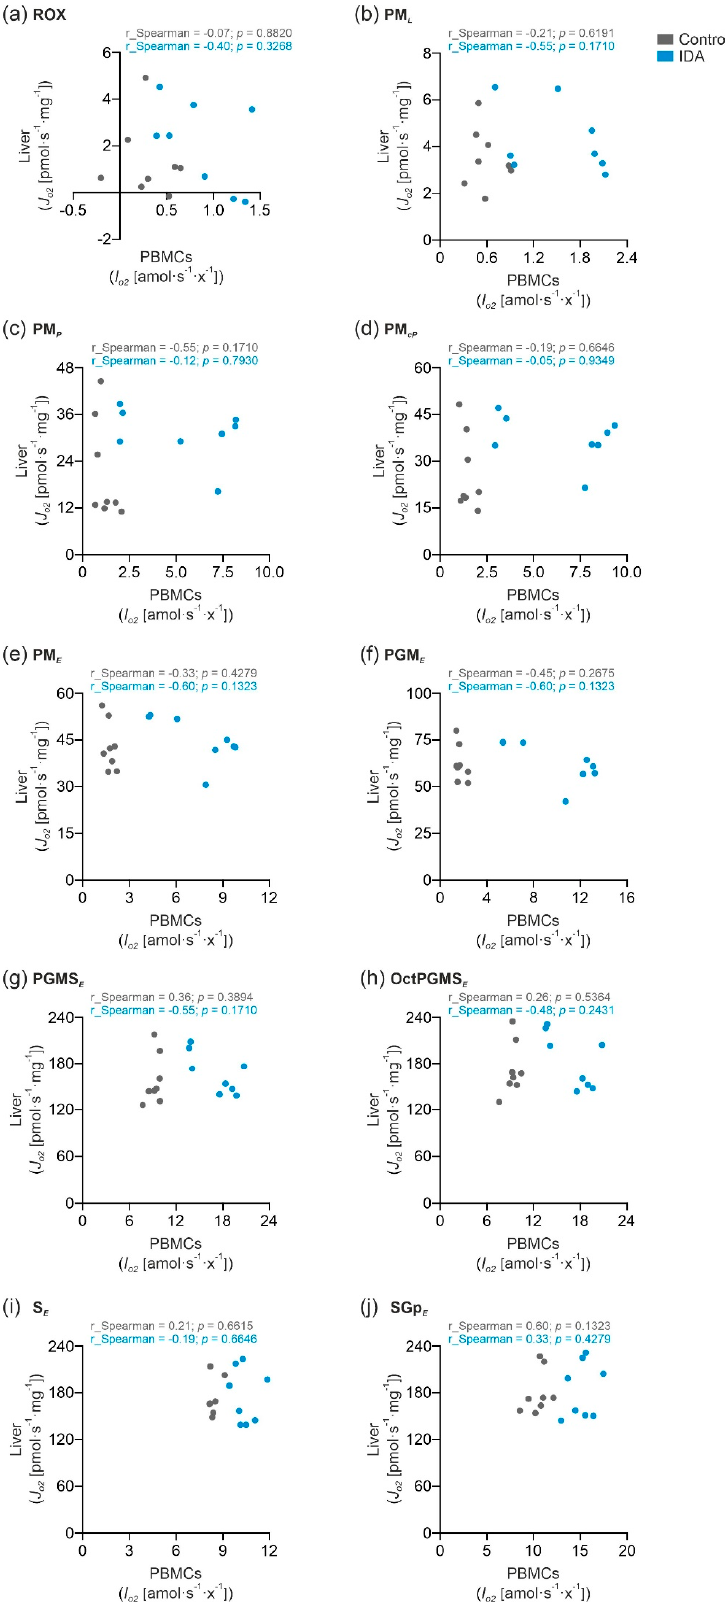
Figure 5. Correlation analysis of PBMC mitochondrial respiration and liver mitochondrial respiration in control and IDA. Spearman’s rank correlation in the measured respiratory states in PBMCs and